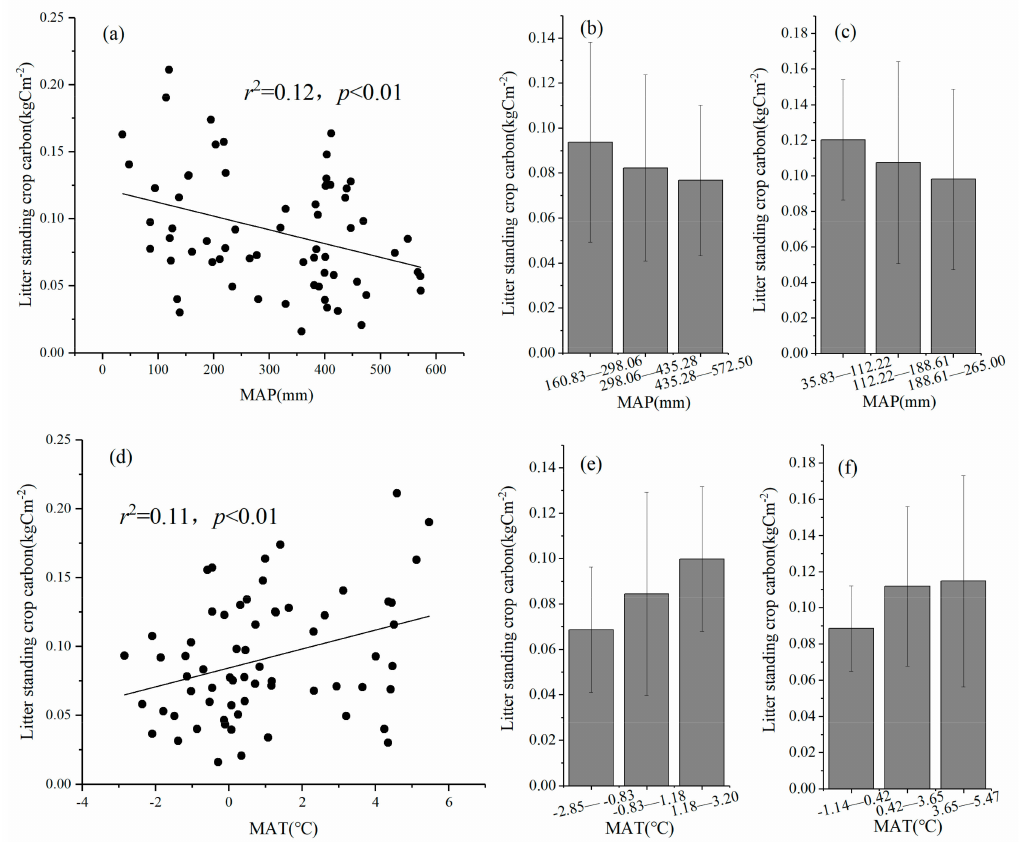
Figure 4. Relationships among mean annual precipitation (MAP) and mean annual temperature (MAT) and litter standing crop carbon, ( a , d ) total shrublands, ( b , e ) alpine shrublands, ( c , f ) desert